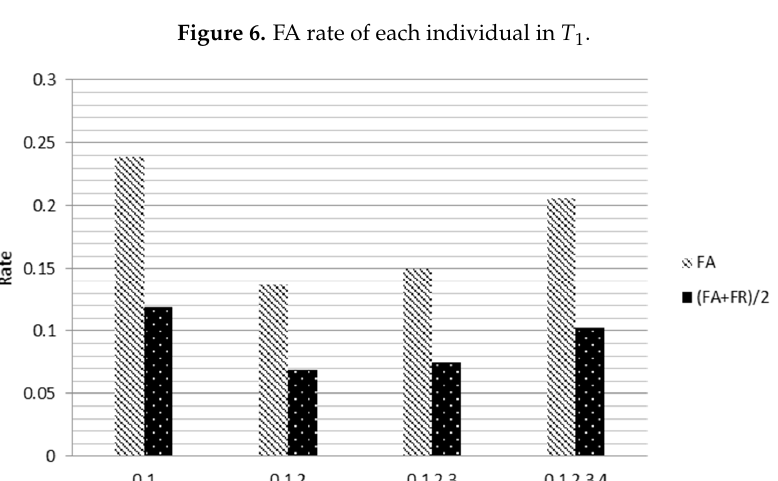
Figure 7. Comparison of different quantization intervals; three-level (0, 1, 2) quantization has the best performance with the lowest FA + FR rate at 0.1193.